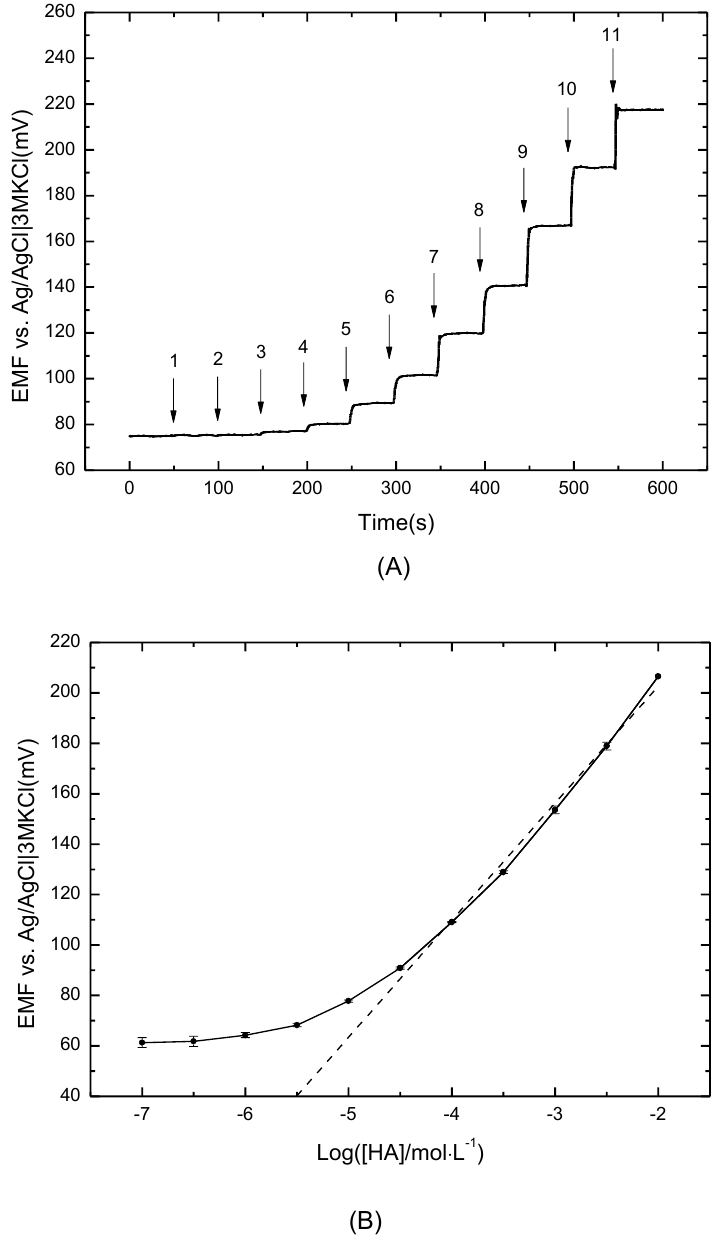
Figure 3. ( A ) Dynamic responses of histamine sensor with the addition of histamine stock solution Fig. 2. (A) The response of HA sensor with increasing HA concentrations from 10 -7 M to 10 -1 M: (1) 10 -7 M; every 50 s (1: 10 − 7 M; 2: 3 × 10 − 7 M; 3: 10 − 6 M; 4: 3 × 10 − 6 M; 5: 10 − 5 M; 6: 3 × 10 − 5 M; 7: 10 − 4 M; (2) 3 × 10 -7 M; (3) 10 -6 M; (4) 3 × 10 -6 M; (5) 10 -5 M; (6) 3 × 10 -5 M; (7) 10 -4 M; (8) 3 × 10 -4 M; (9) 10 -3 M; (10) 8: 3 × 10 − 4 M; 9: 10 − 3 M; 10: 3 × 10 − 3 M; 11: 10 − 2 M); ( B ) Calibration curve of dynamic response in histamine solutions with the background of acetic buffer 3 × 10 -3 M; (11) 10 -2 M; (B) The calibration curve of response to HA solutions in acetate buffer.